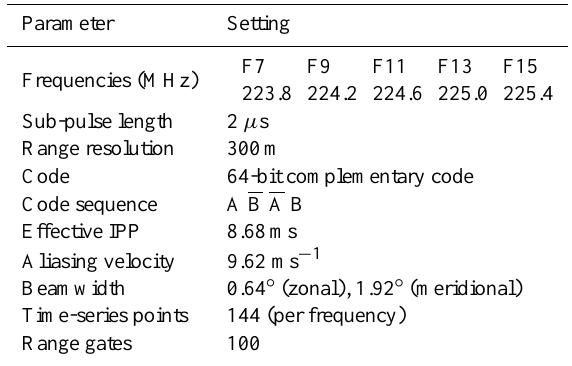
Fig. 1. Block diagram of the EISCAT VHF digital receiver system. BPF and LPF designate the band-pass and low-pass filters, respec-